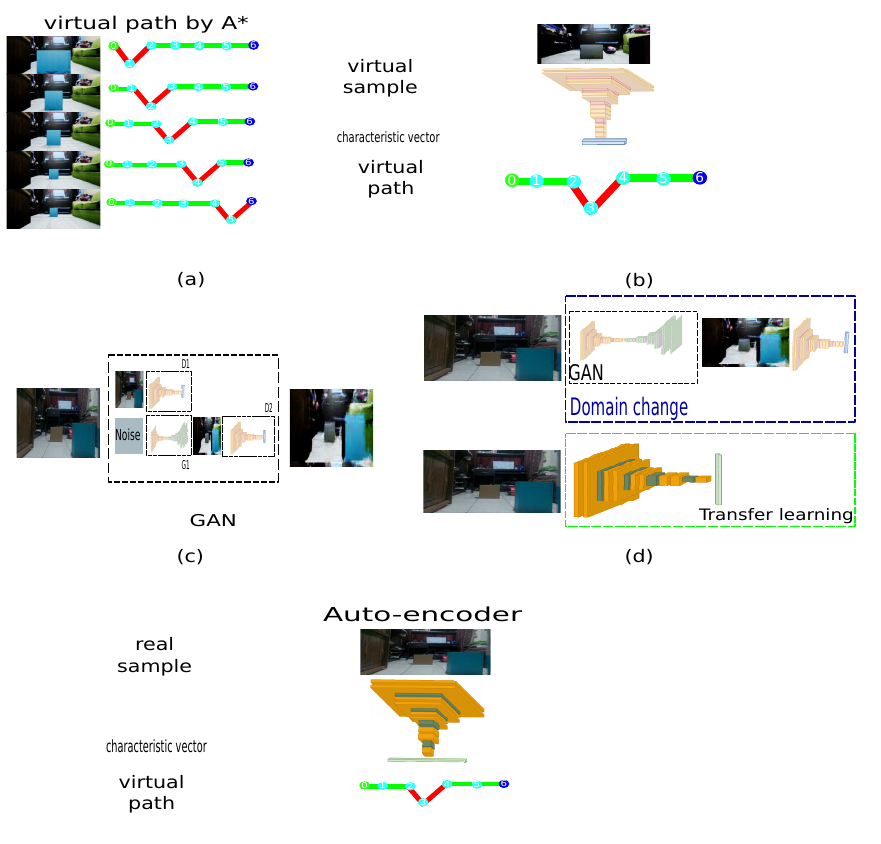
Figure 15. Interoperability between real and virtual environments by a GAN. ( a ) Each virtual sample has an associated virtual path based on A ∗ with metadata. ( b ) An autoencoder estimates the virtual path. ( c ) GAN to connect the real and virtual domains. ( d ) Transfer learning approach to reduce the domain change generated by the GAN. ( e ) The transfer learning model replaces the original to estimate the characteristic vectors, connecting real samples to virtual paths with metadata